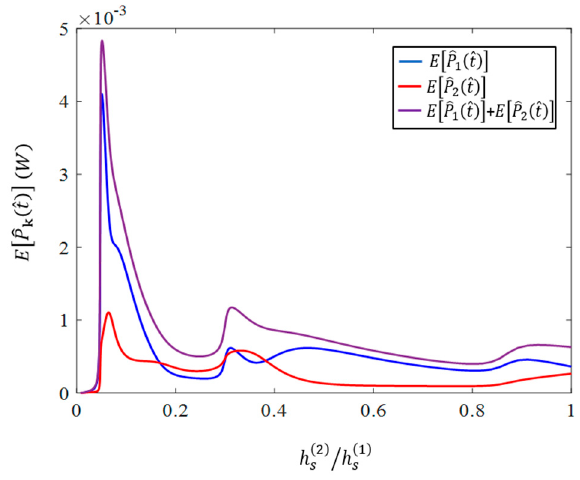
( 2 ) ( 1 ) (cid:3046)((cid:2870)) ℎ (cid:3046)((cid:2869)) (cid:3415) . Figure 10. Mean value of the harvested powers versus the thickness ratio of the beams h s / h s .